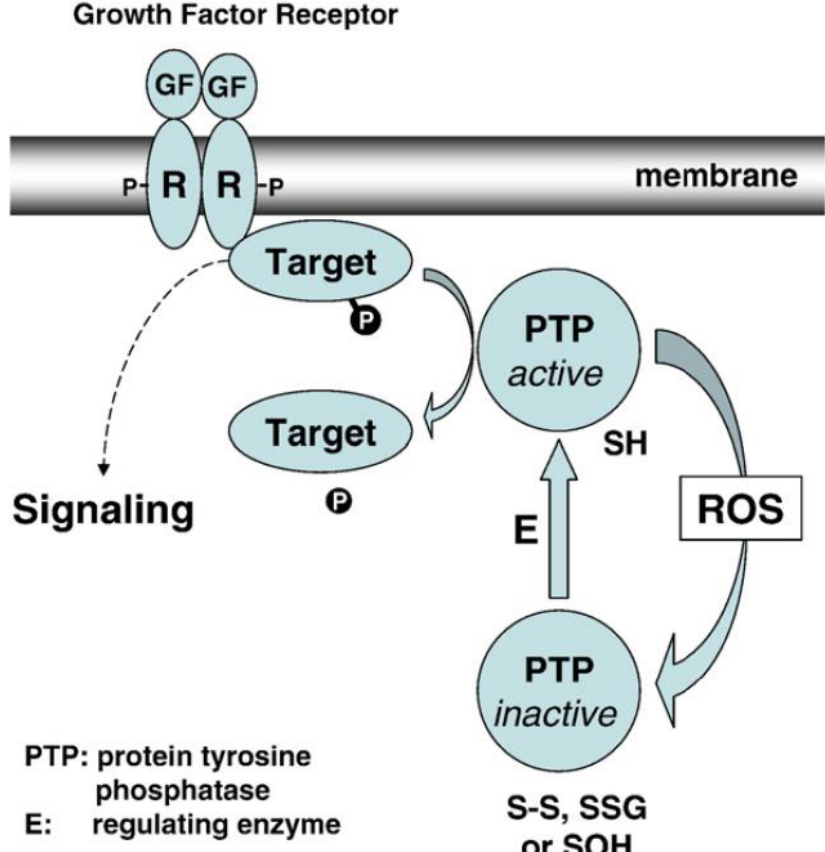
Figure 14. Hypothesis on the function and redox regulation of LMW-PTP in human lens epithelial cells. Growth factor (GF)-mediated mitogenic cell signaling begins by binding at the cell membrane to initiate autophosphorylation (P) at the receptor (R) and downstream target molecules (target-P) from protein tyrosine kinase. GF binding-induced in situ ROS oxidizes active PTP-SH (protein tyrosine phosphatase, such as LMW-PTP) to its inactive form (PTP with-S-S-, S-S-G or S-OH). Inactive PTP is reduced and activated back to PTP-SH by E (regulating enzyme system, such as TTase) to dephosphorylate and inactivate target proteins (target + P), allowing the completion of cell signaling. Reprinted with permission from Xing et al., BBA (2007) ; Copyright Elsevier 2007 [100].